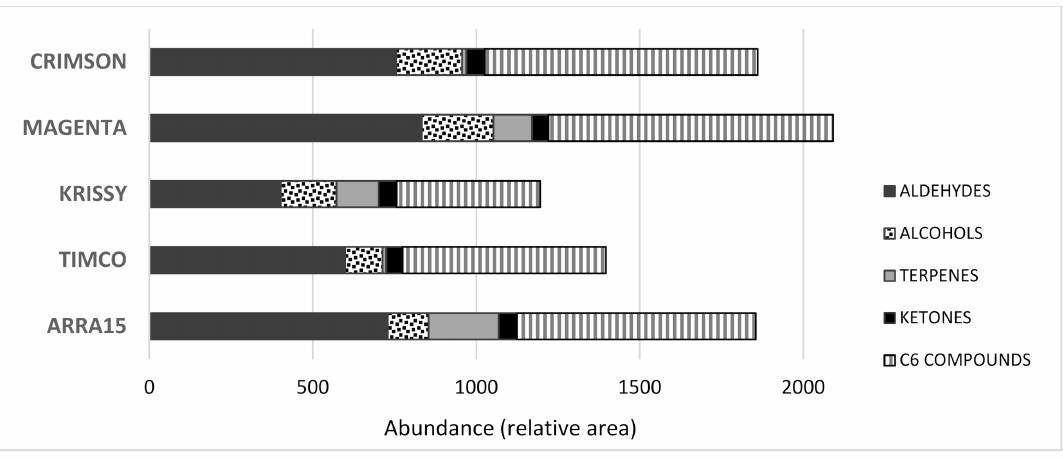
Figure 2. Total amounts of volatile compounds found in the table grapes